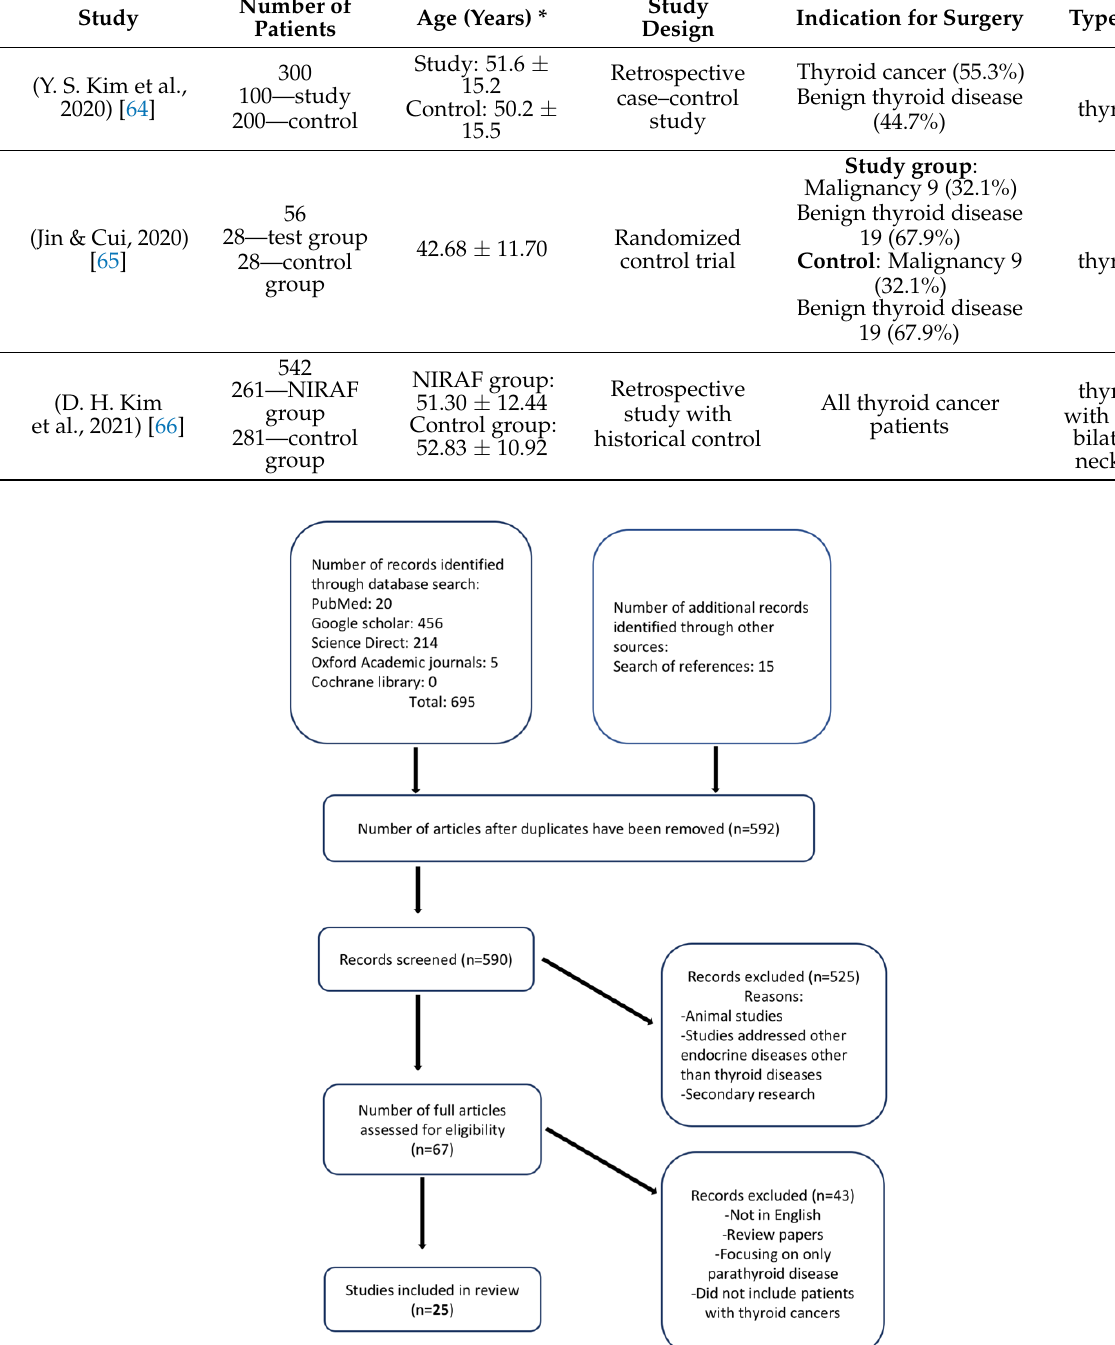
Figure 1. Flow diagram of study selection.